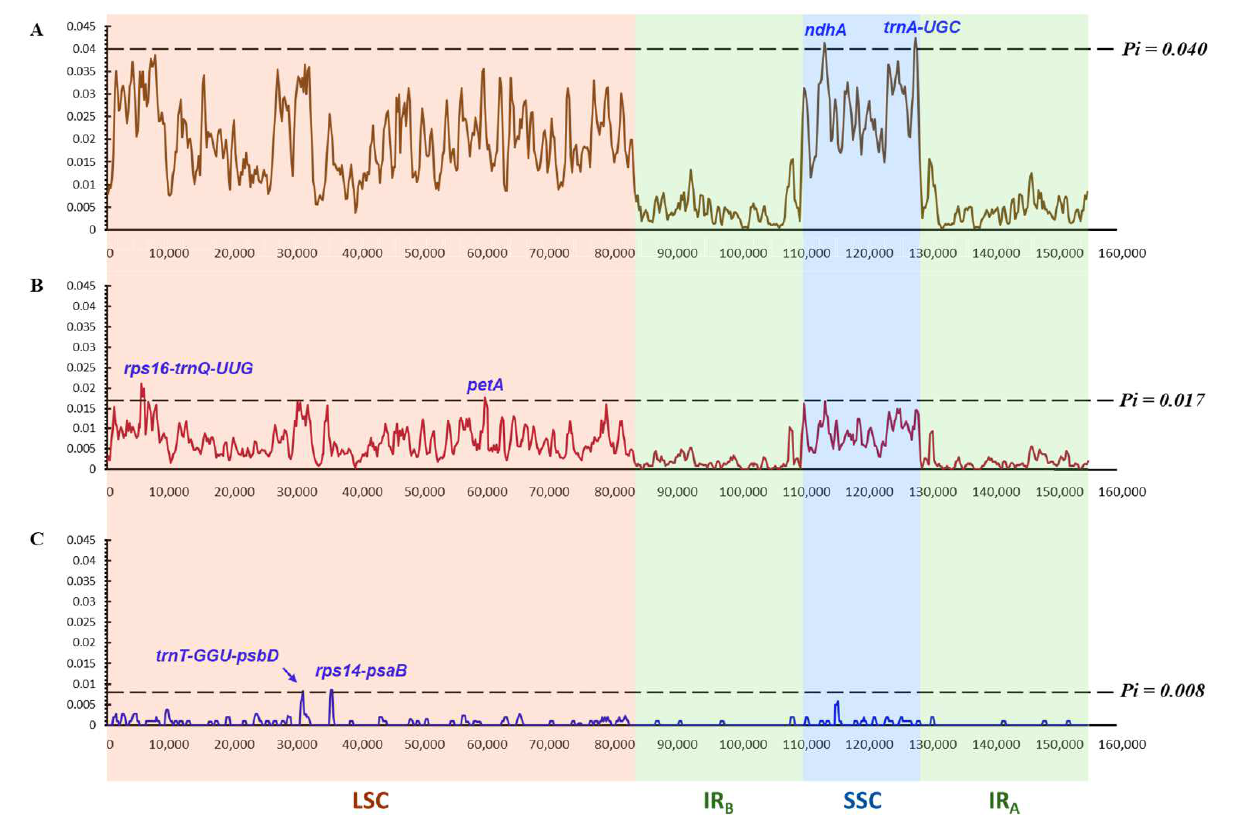
Figure 9. Nucleotide diversity values (Pi) of different combinations of Scilloideae chloroplast genomes. ( A ) Fifteen chloroplast genomes of Scilloideae including chloroplast genomes of Scilla siberica , Bellevalia paradoxa , Hyacinthoides non-scripta , Albuca kirkii , Oziroe biflora, seven Hyacinthus cultivars and three Barnardia japonica . ( B ) The nine newly de novo assembled chloroplast genomes in this study, including the chloroplast genomes of Scilla siberica , Bellevalia paradoxa and seven Hyacinthus cultivars. ( C ) Only the chloroplast genomes of seven Hyacinthus cultivars. The partitions of chloroplast genome were abbreviated as the following: Large Single Copy—LSC; IR B —Inverted Repeat B; Small